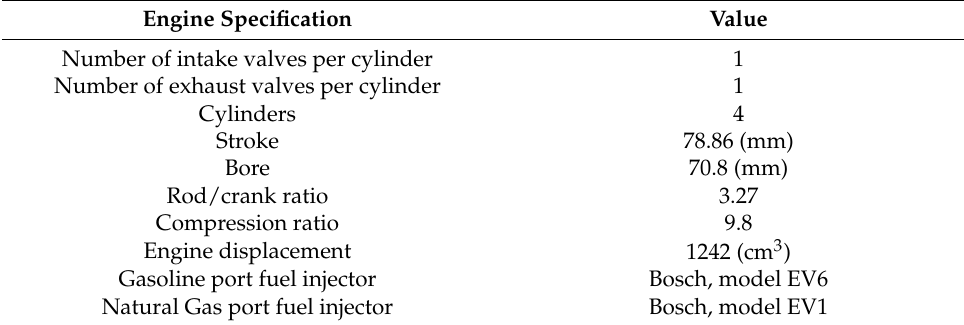
Table 1. Engine technical features.